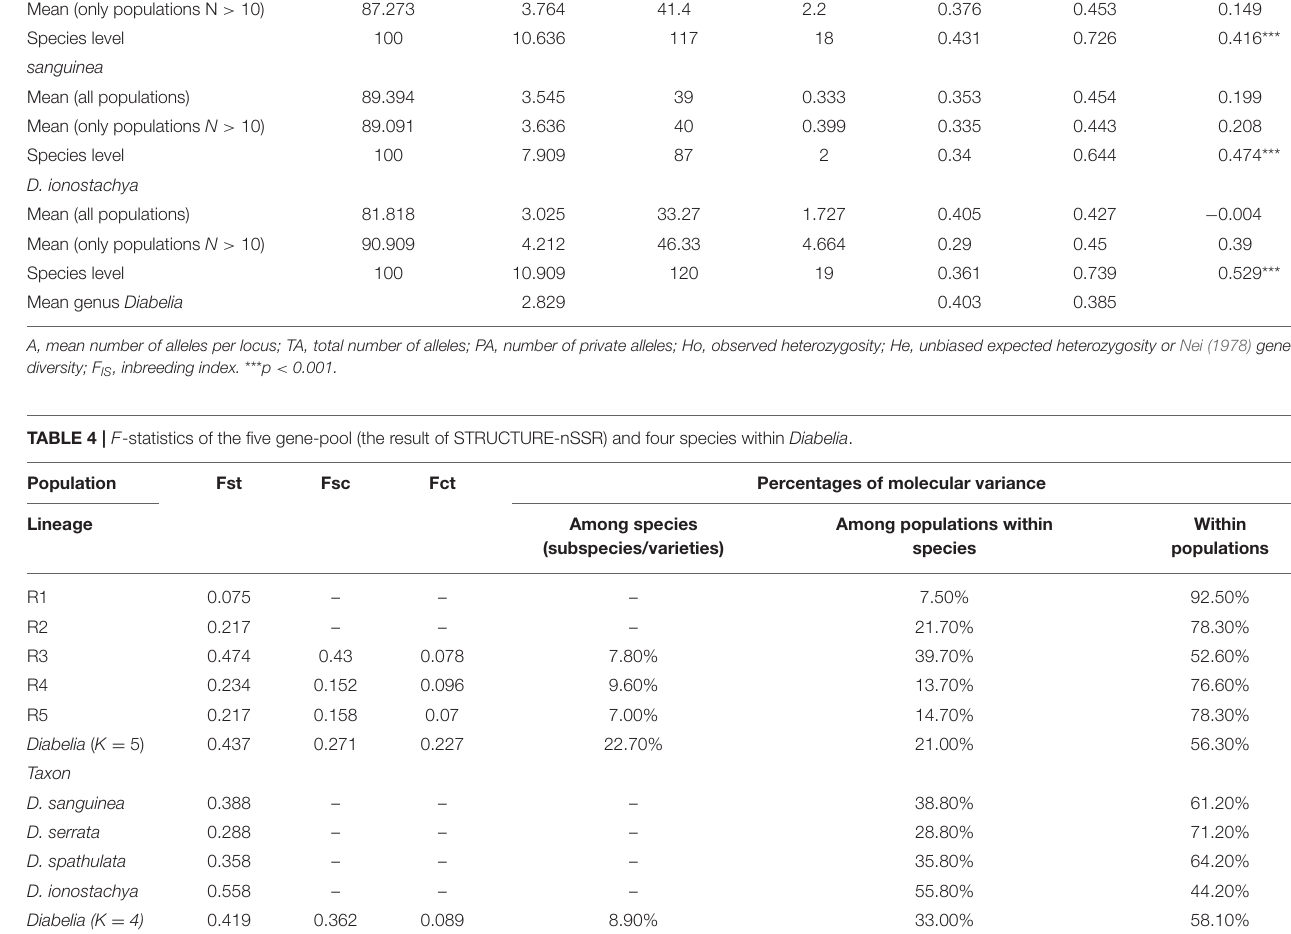
TABLE 3 | Analysis of molecular variance (AMOVA) and gene-frequency of Diabelia within species, areas and total based on nSSR and chloroplast DNA variation. Population P (99%) A TA PA Ho